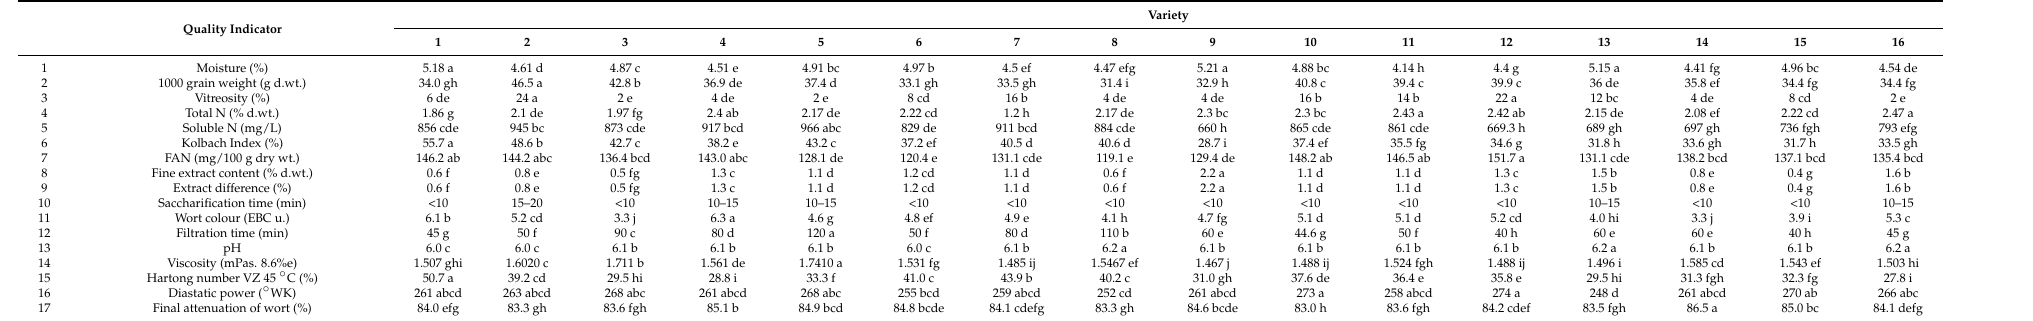
Table 10. Results of wheat malt analysis (procedure D).